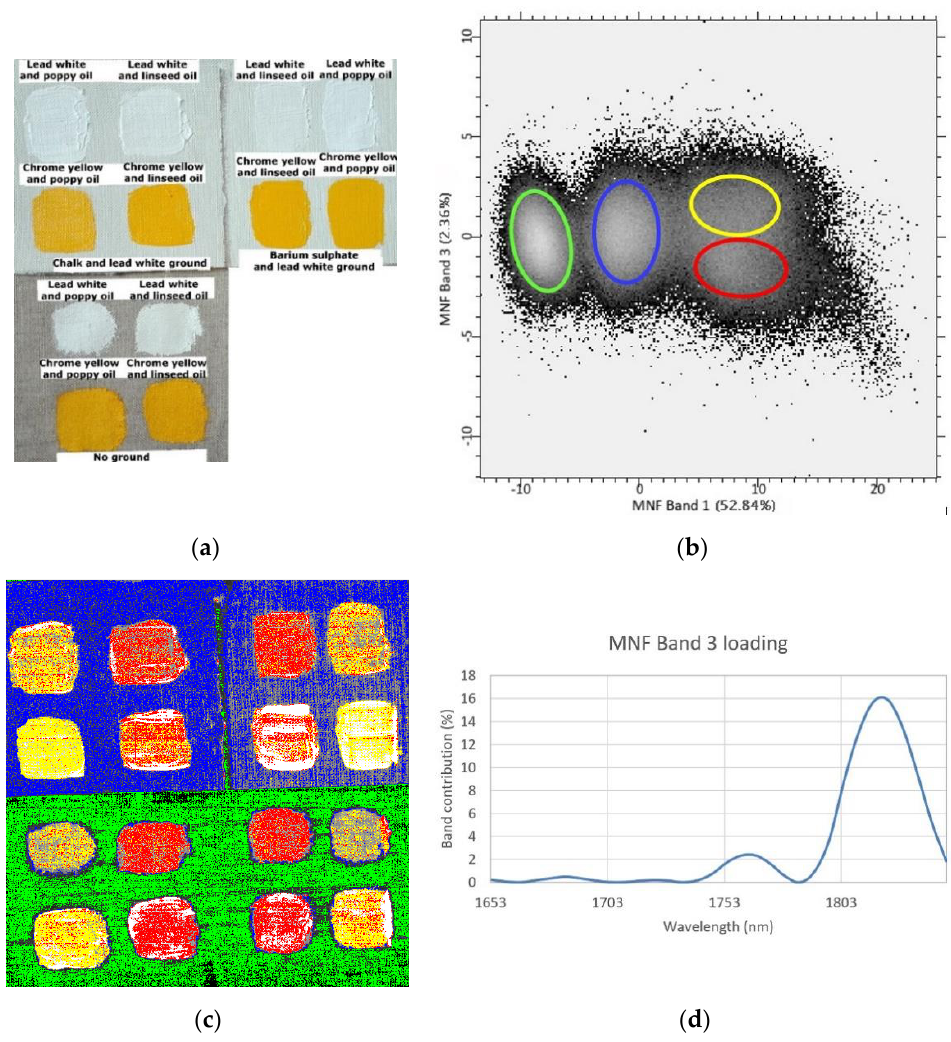
Figure 5. ( a ) Visible light image of the samples; ( b ) scatter plot of minimum noise fraction transform (MNF) band 1–band 3. Range 1653–1848 nm. The different classes identified in the scatter plot have been highlighted by hand using different colours and their distribution in the samples is visualized in the classified image; ( c ) classified image based on the classes identified in the scatter plot; ( d ) loading plot of MNF band 3.